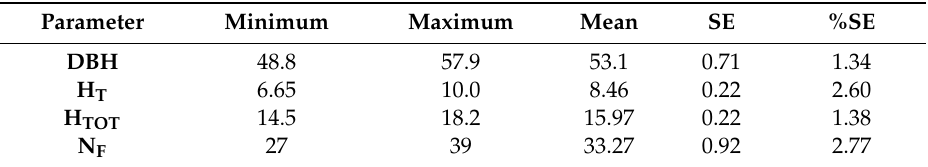
Table 1. Summary of the field measurements for 18 felled oil palms: n is the number of oil palms; DBH, H T , H TOT and N F are respectively the diameter at breast height (cm, measured 1.3 m above the ground surface), the stem height (m), the total height (m) and the leaf number per tree.